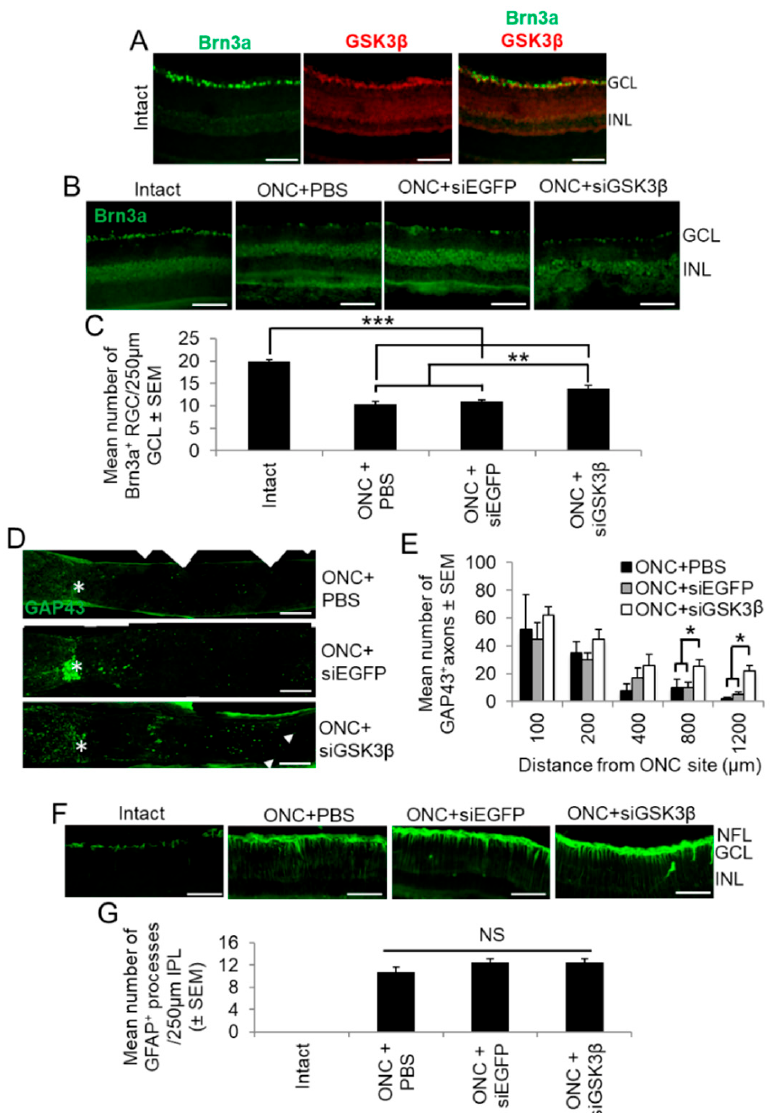
Figure 7. Cellular localisation of GSK3 β and the effects of siGSK3 β on RGC neuroprotection in vivo. ( A ) Retinal sections from uninjured adult rats immunostained for Brn3a (green) and GSK3 β (red), demonstrating that constitutive expression of GSK3 β was limited to the GCL, where it localised to Brn3a + RGC (INL = inner nuclear layer). ( B ) siGSK3 β protects RGC (Brn3a + ) from death at 24 days after ONC, compared to ONC + PBS and ONC + siEGFP. Intact uninjured controls show baseline levels of Brn3a + RGC. ( C ) Quantification of Brn3a + RGC survival in the 250 µm counting area of the GCL. (Scale bars in A and B = 100 µm; ** = p < 0.01; *** = p < 0.001). ( D ) Longitudinal ON sections immunostained to demonstrate GAP43 + regenerating axons (arrows) after ONC + PBS (top panel), ONC + siEGFP (middle panel) and ONC + siGSK3 β (bottom panel). The asterisk demarcates the ON site and the boxed area in the lower panel represents the magnified area. ( E ) Quantification of GAP43 + regenerating axons 100, 200, 400, 800, and 1200 µm beyond the ONC site in eyes after intravitreal injection of PBS, siEGFP, and siGSK3 β . (Scale bars = 200 µm; * p < 0.05). ( F ) GFAP + glial activation occurs after ONC and is not further enhanced by siGSK3 β treatment. ( G ) Quantification of the number of GFAP + glial processes crossing a 250 µm line in the inner plexiform layer corroborates this observation. (Scale bar in F = 100 µm; NS = not significant). n = 6 eyes (from 6 rats)/treatment.